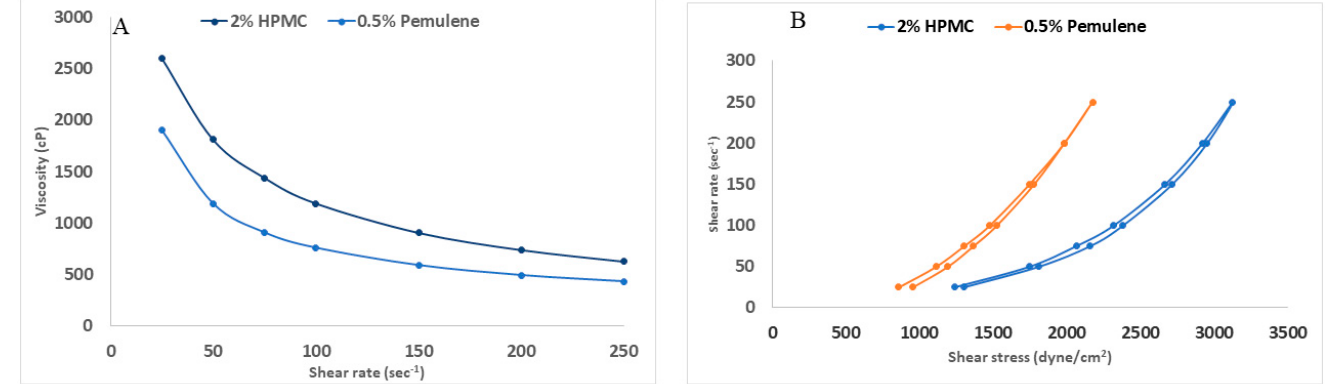
Figure 7. Rheological parameters of the prepared zolmitriptan NLCs loaded gels: viscosity determi- nation ( A ) and hysteresis loop measurement ( B ).